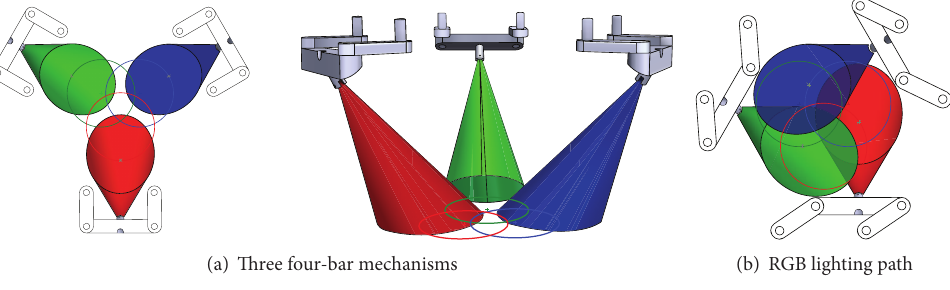
Figure 4: 3D simulation of color mixing mechanism.